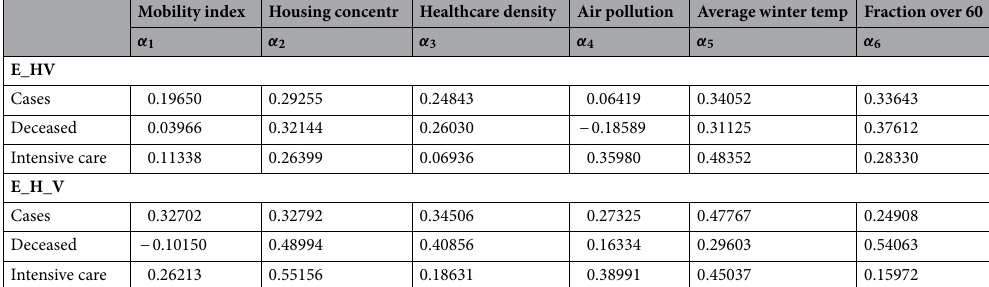
Table 5. Normalized coefficients α i , i = 1, . . . , 6 of both E_HV and E_V_H models, in the versions